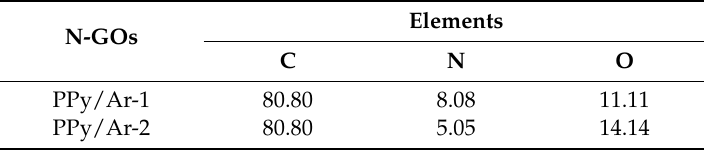
Figure 8. XPS spectrum obtained for N-GOs PPy/Ar-1 (thick line) and PPy/Ar-2 (dotted line). Table 2. Elemental composition of N-GOs PPy/Ar-1 and PPy/Ar-2.